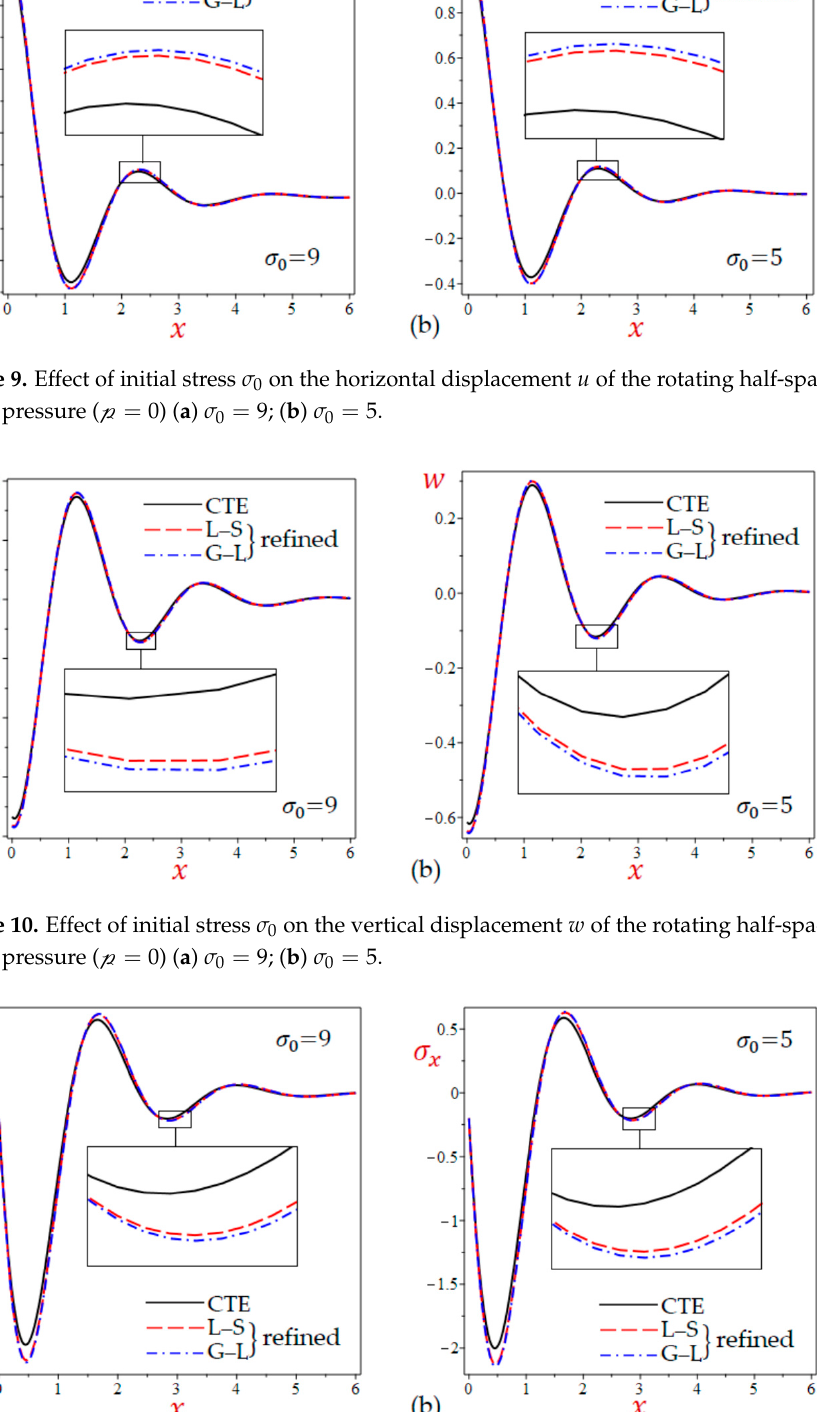
Figure 11. Effect of initial stress σ 0 on the longitudinal normal stress σ x of the rotating half-space